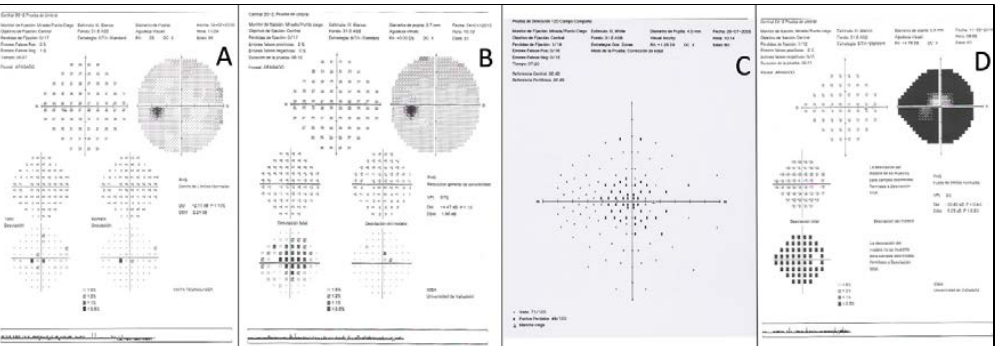
Figure 5. Examples of visual fields (VFs). ( A ) Small paracentral scotoma from F3-V-2 with PDsFF. ( B ) Central scotoma from F5a-III-2 with CACD. ( C ) A large central scotoma from F2-III-6 with ECA. ( D ) Concentric VF restriction from F7-III-1 with ADRP.